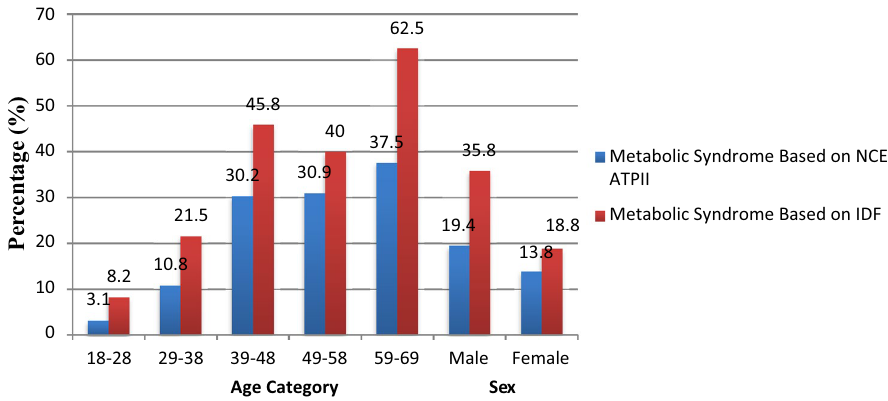
Figure 1. Prevalence of Metabolic Syndrome Based on NCEP ATP III and IDF criteria stratified by Age Group and Sex of Participants EPHI, Addis Ababa, Ethiopia,